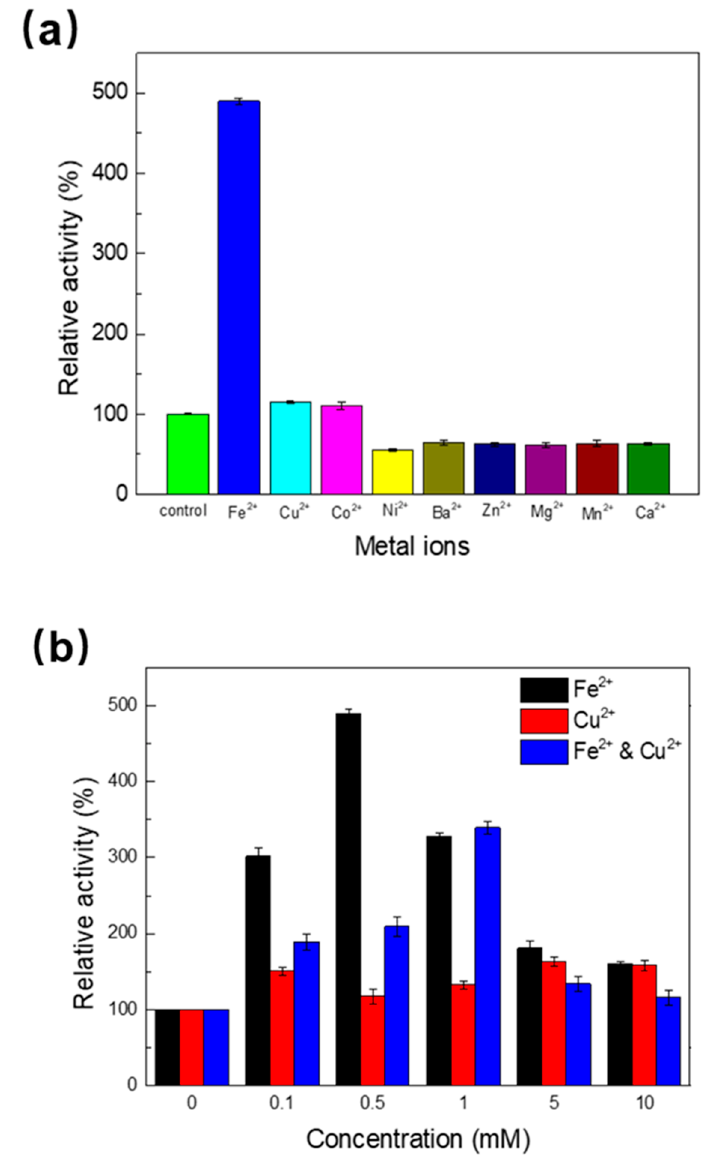
Figure 5. Activity of Melac13220 after 1 h of pre-incubation in the presence of various metallic ions in the reaction mixture ( a ) and at 0.1 mM, 0.5 mM, 1 mM, 5 mM and 10 mM concentration of Fe 2+ , and Cu 2+ ( b ). The enzyme activity in the absence of metal ions was regarded as 100%. The data represented as the mean ± standard deviation from at least independent